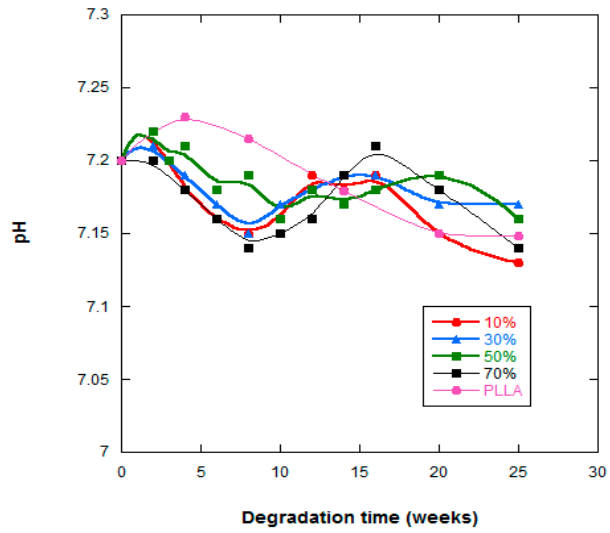
Figure 5. pH of the PBS solution vs. degradation time of PLLA, PLLA-10%Fe 3 O 4 , PLLA-30%Fe 3 O 4 , PLLA-50%Fe 3 O 4 and PLLA-70%Fe 3 O 4